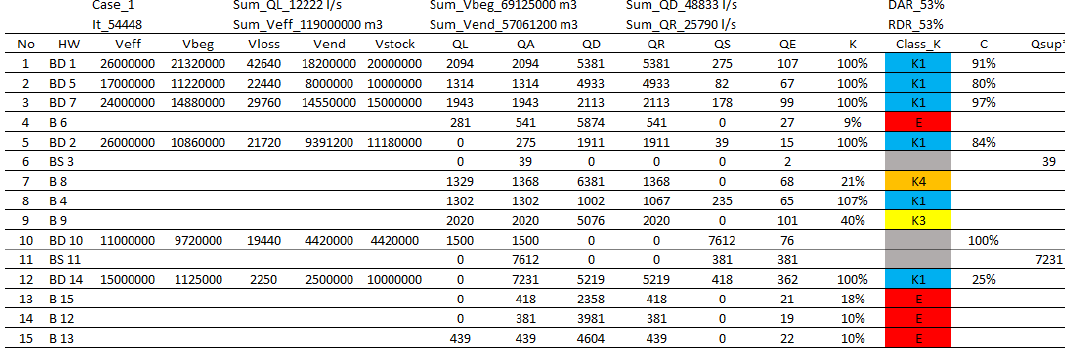
Figure 12. Computation output with FCFS method.